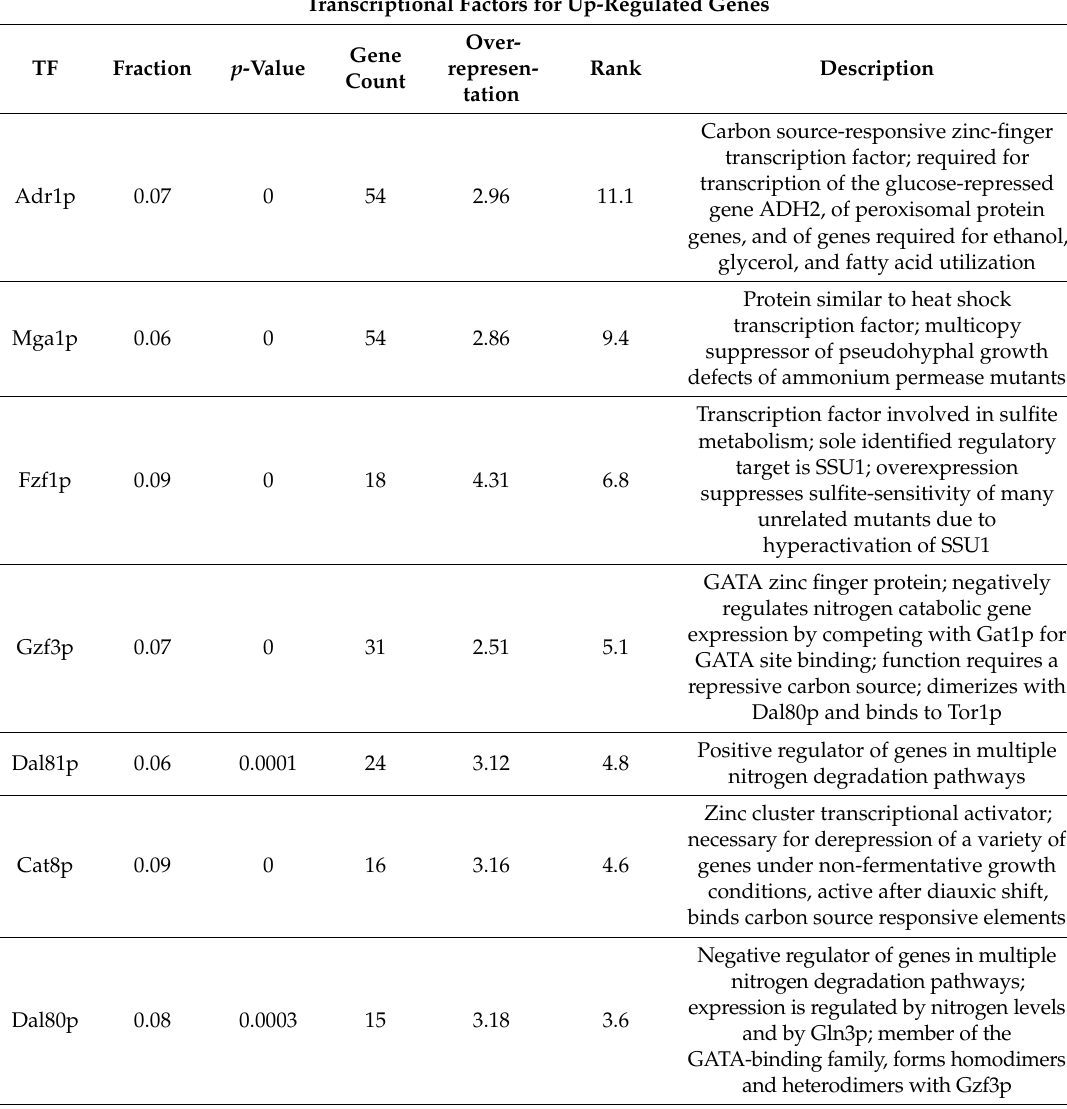
Table 1. Transcriptional factors (TFs) are most strongly involved in the regulation of genes selected in transcriptome analysis. The list was generated with the help of the Yeastract + online database [20] (http: // www.yeastract.com). Each TF name is accompanied by the description of the function according to SGD and with the parameters that were used for filtering the raw TF output list. See the Materials and Methods section for a more detailed description of these parameters and the filtering strategy. The lists are sorted according to the Rank